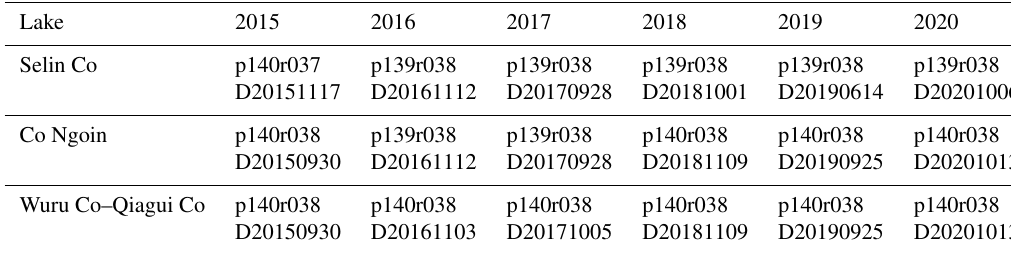
Table A2. Information on the Landsat 8 images used.